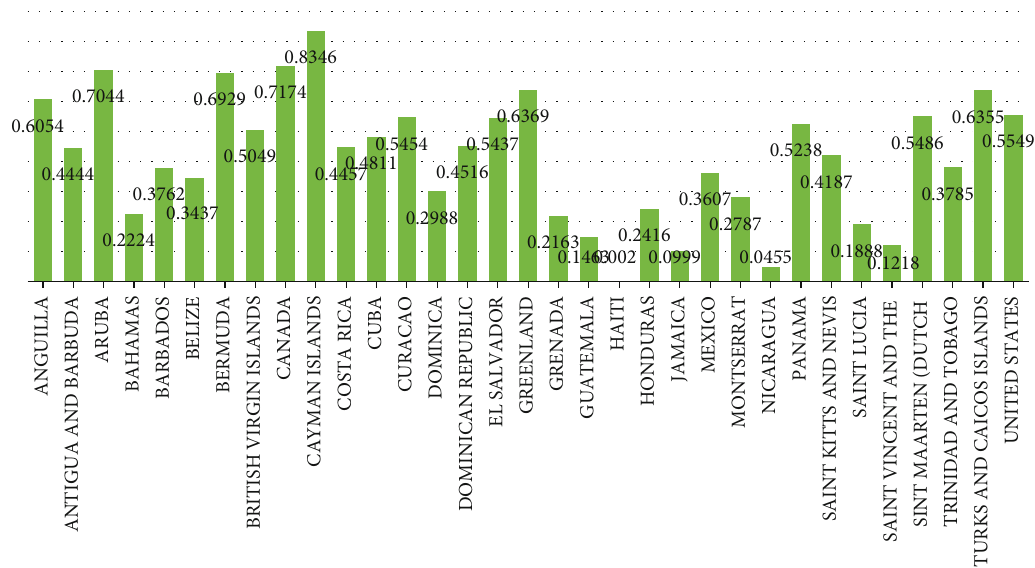
Figure 1: Bar chart of percentage of person completely vaccinated against COVID-19 in North American countries.